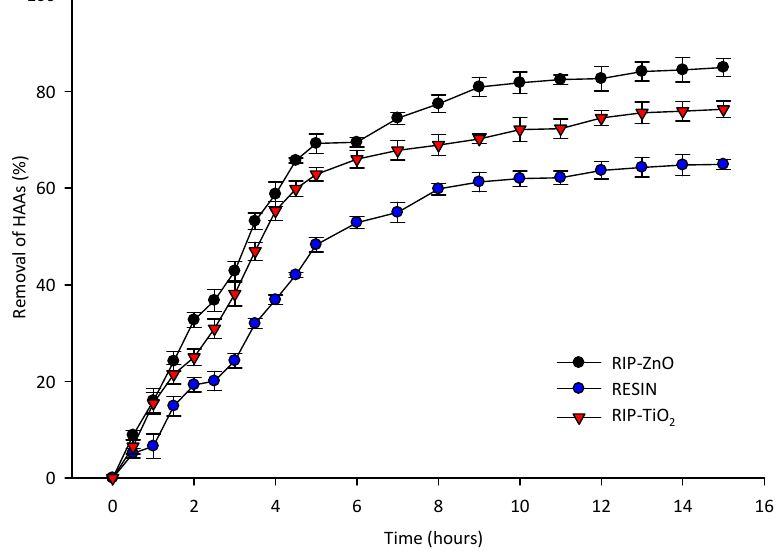
Fig. 5: The changing of HAAs concentration in tofu wastewater under various processes of resin, RIP‐TiO 2 , and RIP‐ZnO